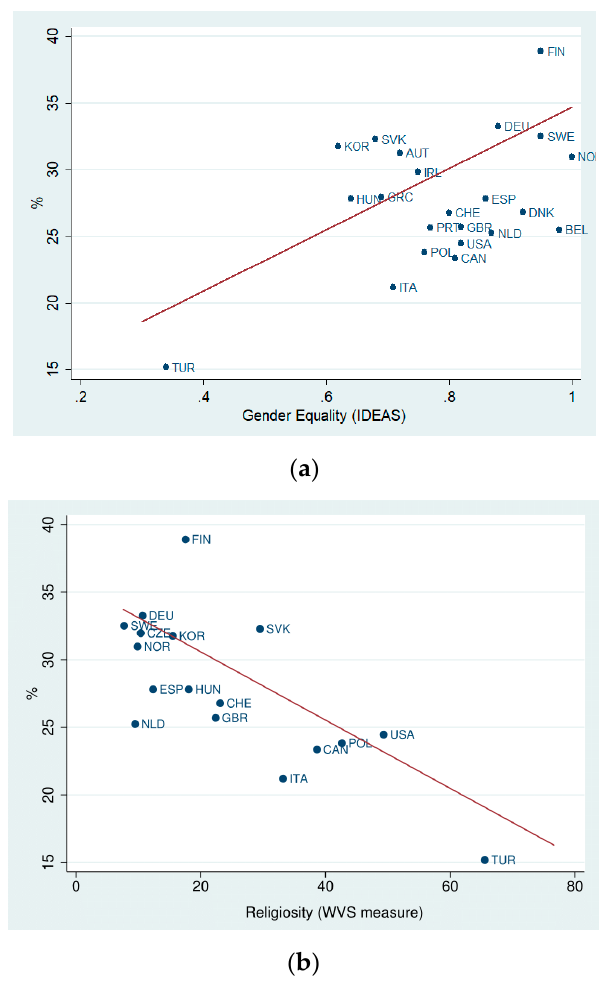
Figure 4. Gender Segregation and Cultural Values. ( a ) Gender Equality, ( b ) Religiosity.